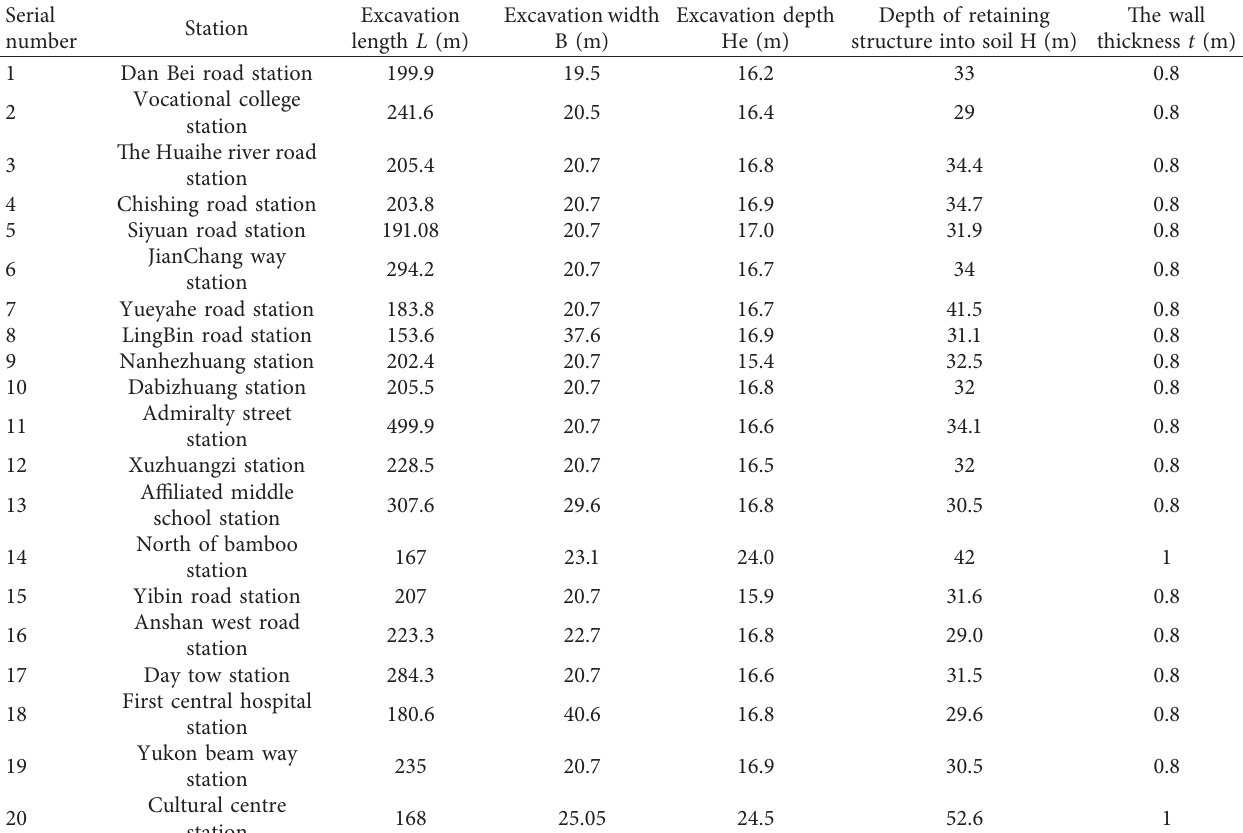
Table 1: The basic statistics of the excavation with an open cut.